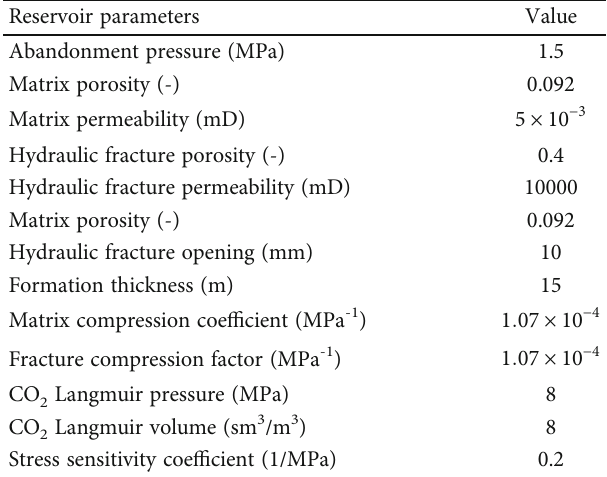
Figure 4: Validation of new proposed model: injection rate Q 100,000 m 3 /d, injection time 365 days. Table 2: Reservoir parameters and production